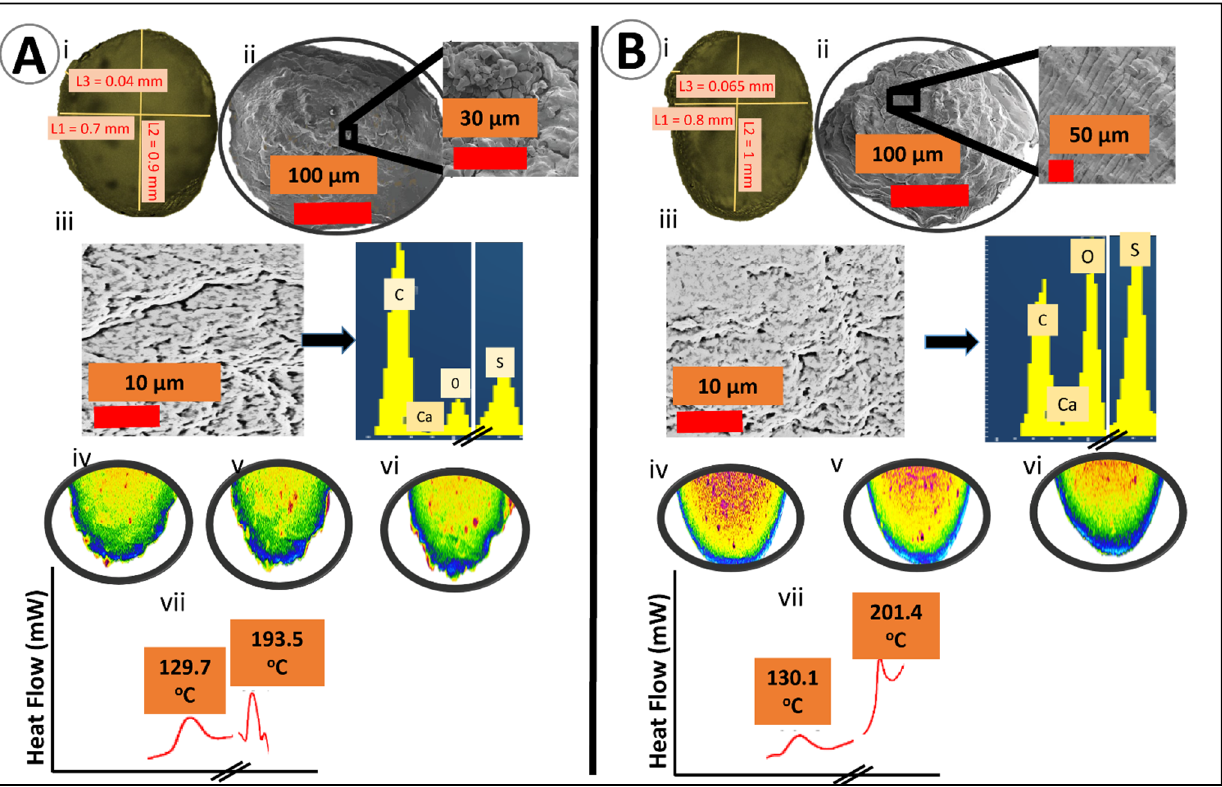
Figure 2. ( A ) F-1; PB-SA microcapsules; (i) optical image, (ii) SEM image at 100 µ m, (iii) EDXR spectra and corresponding analysis, (iv–vi) micro-CT-analysis reflecting the internal structure and morphology, (vii) DSC thermograms. ( B ) F2; PB-LCA-SA microcapsules; (i) optical image, (ii) SEM image at 100 µ m, (iii) EDXR spectra and corresponding analysis, (iv–vi) micro-CT-analysis reflecting the internal structure and morphology, (vii) DSC